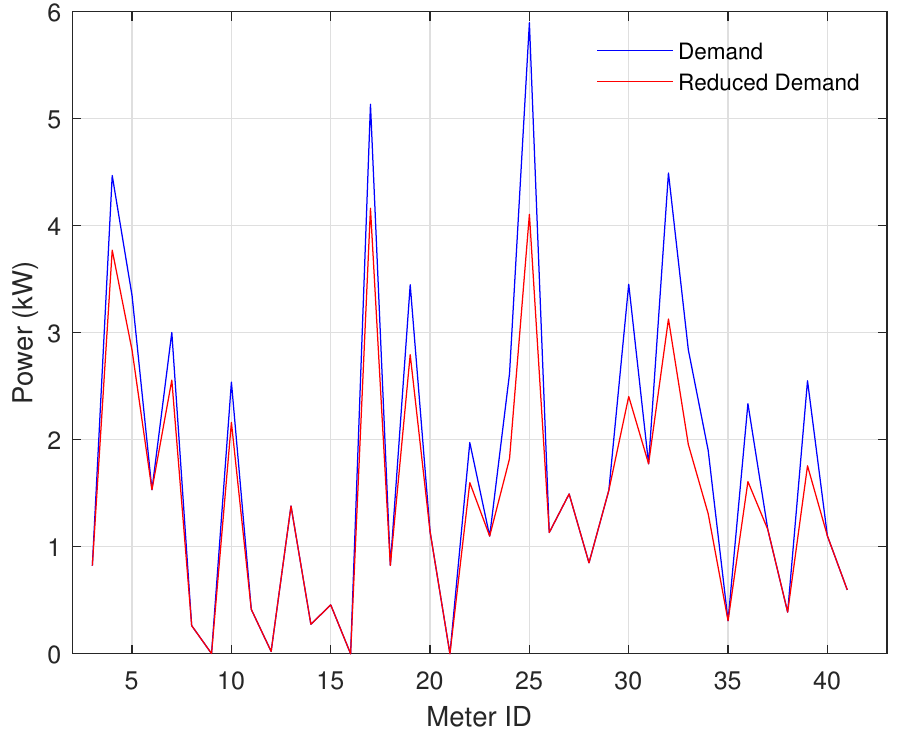
Figure 5. Demand and reduced demand of each consumer after